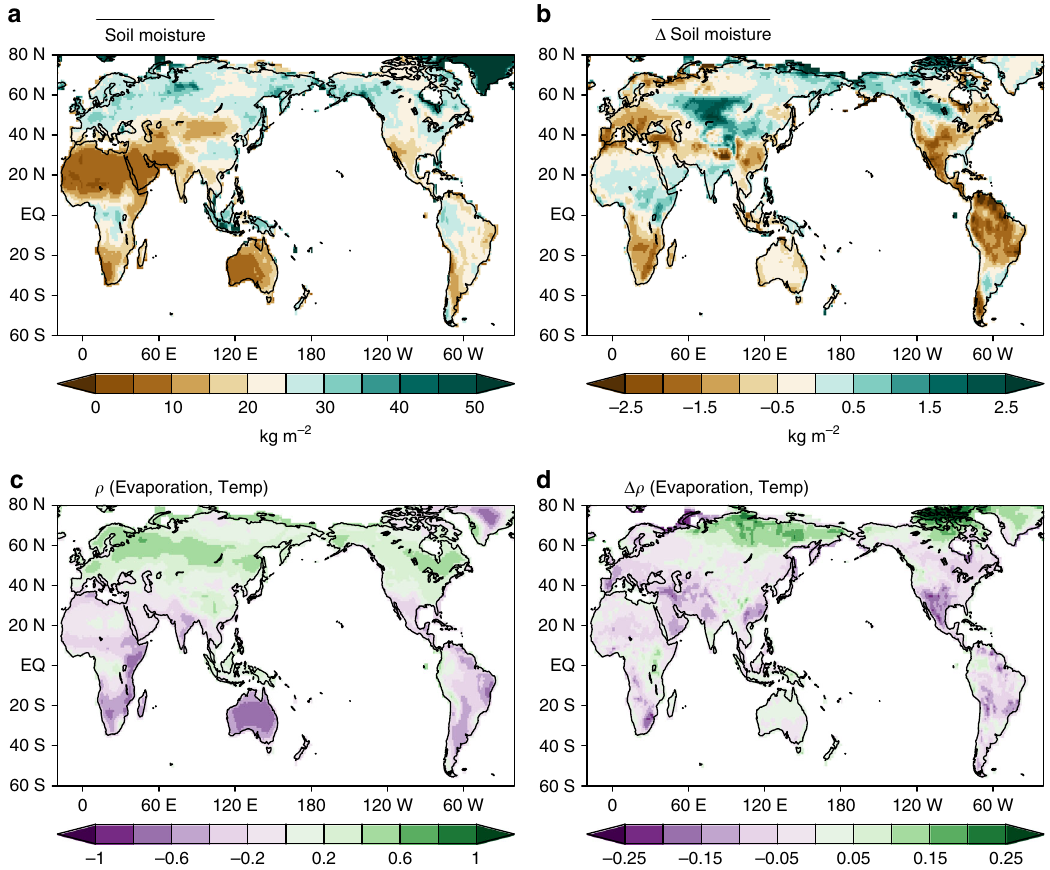
Fig. 4 Soil moisture and evaporation-temperature coupling. a Climatological soil-moisture content from September to February in the preindustrial experiment (kg m − 2 ) and b soil-moisture climatology differences between the preindustrial experiment and ECP4.5 (kg m − 2 ). c Correlation coef fi cients of evaporation at the local surface temperature in the preindustrial experiment, d and the difference in the correlation coef fi cients between the preindustrial experiment and